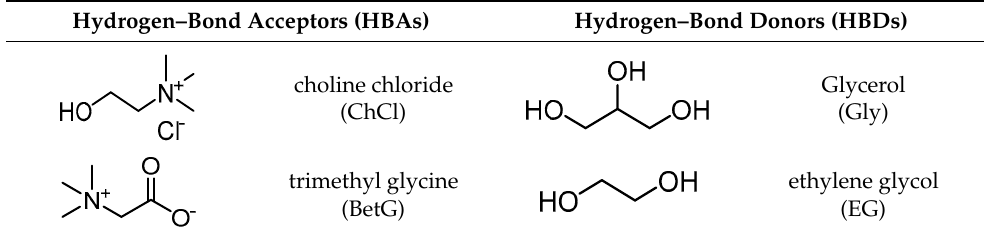
Table 1. Structure, name, and symbols of the HBAs and HBDs used here as components in the preparation of RDESs.